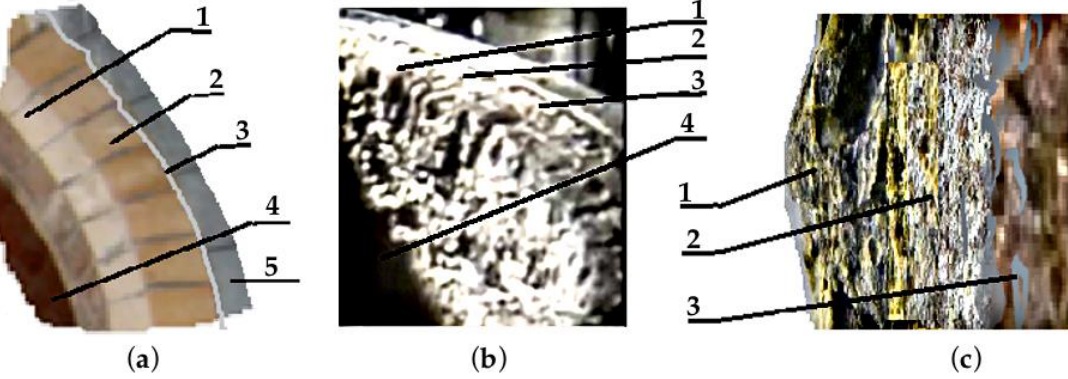
Figure 2. Dinas brick electric arc furnace lining and phase states of quartzite during operation: ( a )